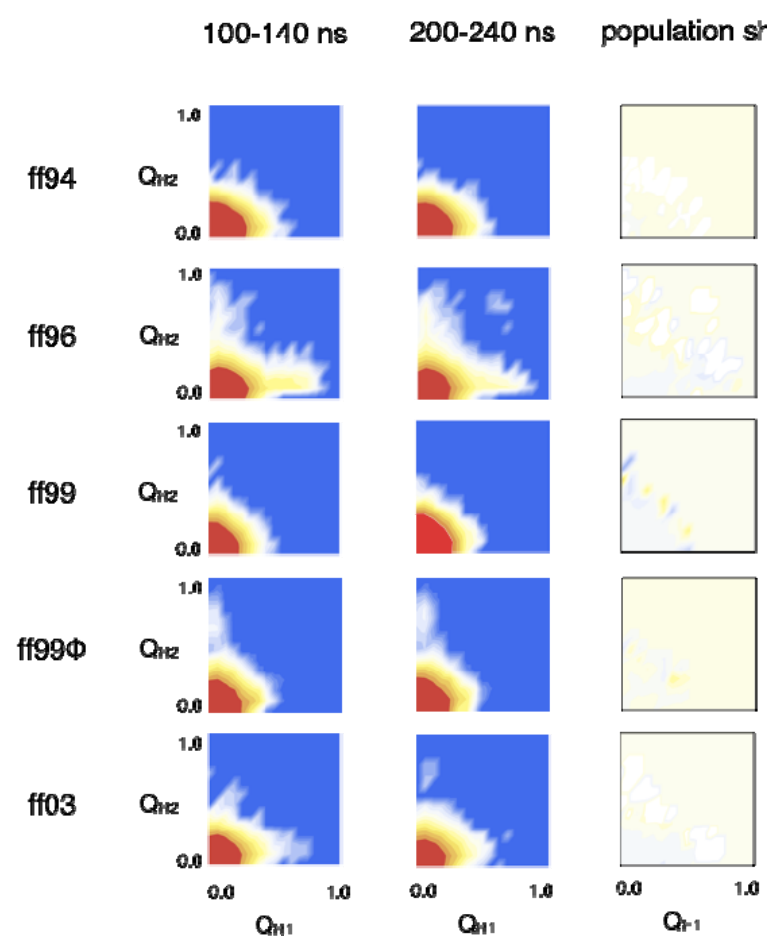
Figure 8. Conformational landscapes for D P D P-II. Histograms of sampled populations were constructed in reaction coordinates Q and Q , which monitor the fraction of hairpin 1 H1 H2 and hairpin 2 contacts, respectively. Populations at times 100-140 ns and 200-240 ns are shown in the first two columns. The third column shows a difference map of the population shift over this time. Distributions are plotted on a log-scale, with each color gradation representing one unit k T of free energy at room B